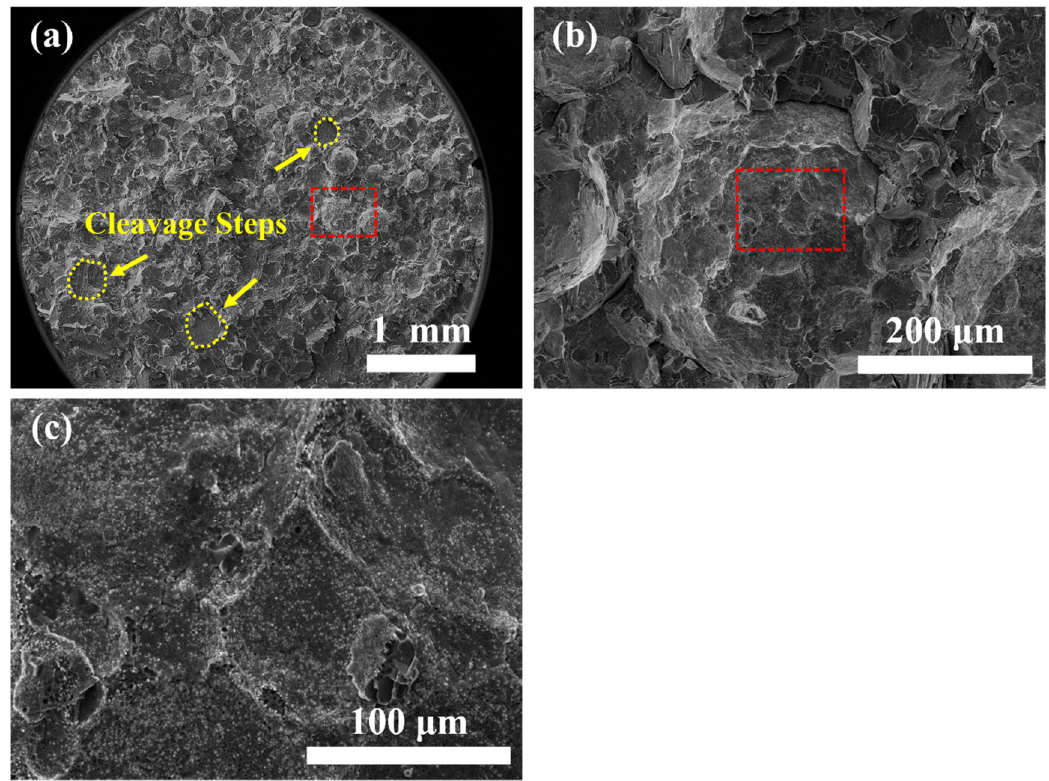
Figure 8. SEM images of the fracture surface of the tensile tested samples: ( a ) macro-morphology and ( b , c ) higher magnification micrograph of the intergranular fracture surface of the as-HIPed sample after tensile tests at 25 °C.